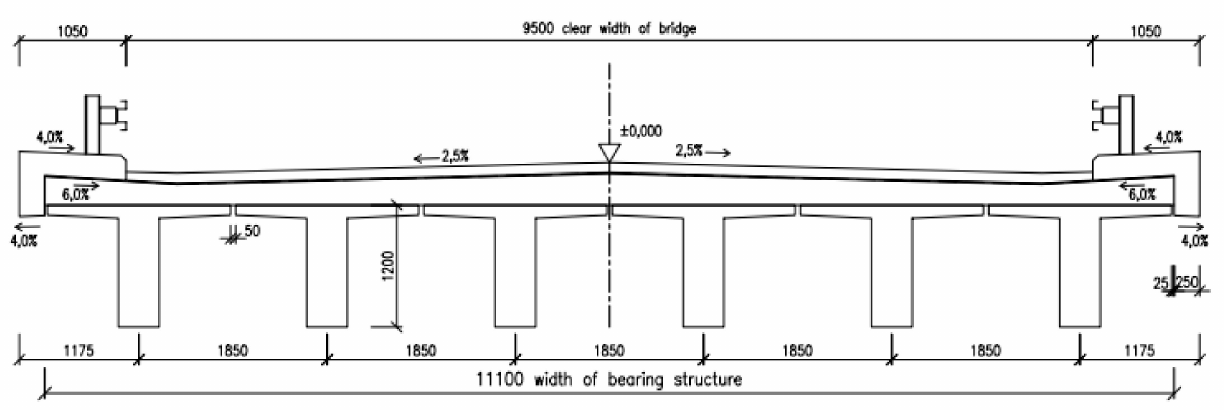
Figure 13. Section of model road